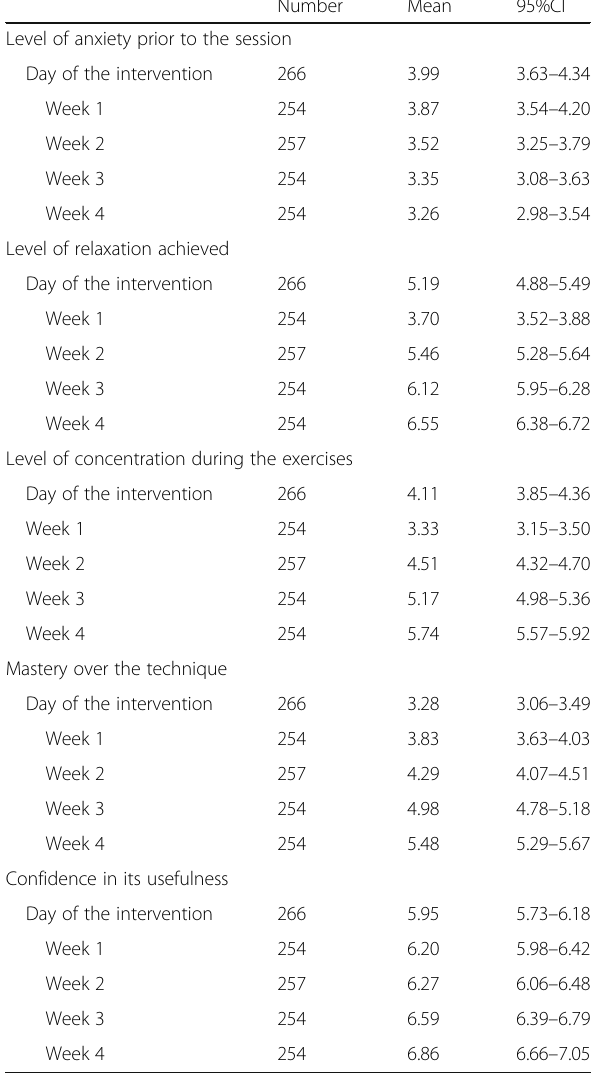
Table 2 Evolution throughout the 4 weeks for anxiety, relaxation, concentration and mastery over the